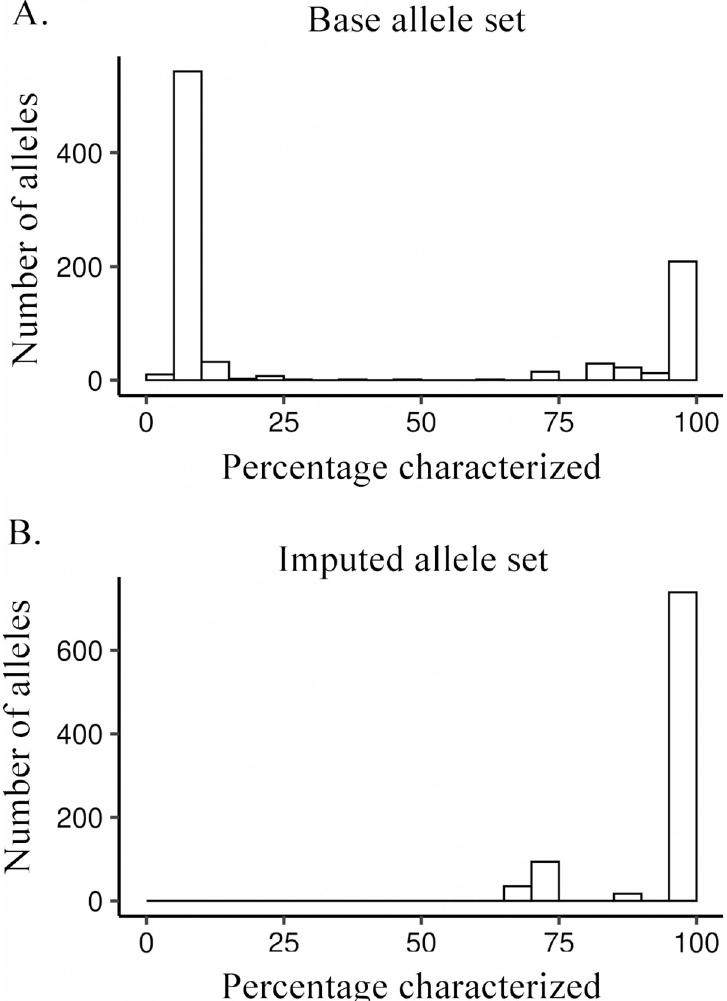
Fig 2. KIR sequence characterization before and after imputation. (A) Histogram of IPD-KIR allele sequence lengths, shown as percentage of longest sequence for each gene and major allele group. (B) Histogram of IPD-KIR allele sequence lengths after imputation, shown as percentage of longest sequence for each gene and major allelic